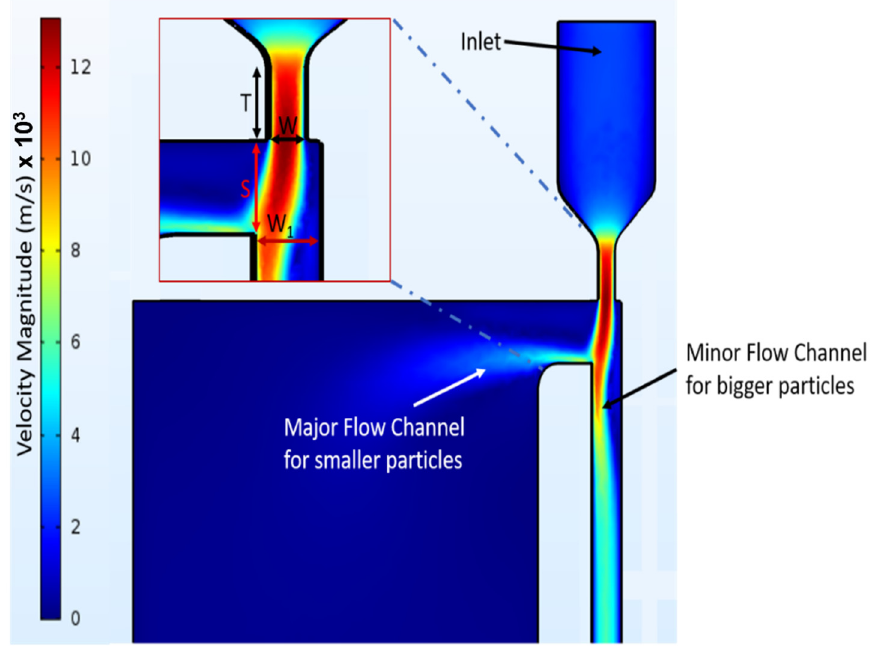
Figure 4. Velocity profile of the virtual impactor from Multiphysics simulations. Table 1. Design parameters of the virtual impactor.